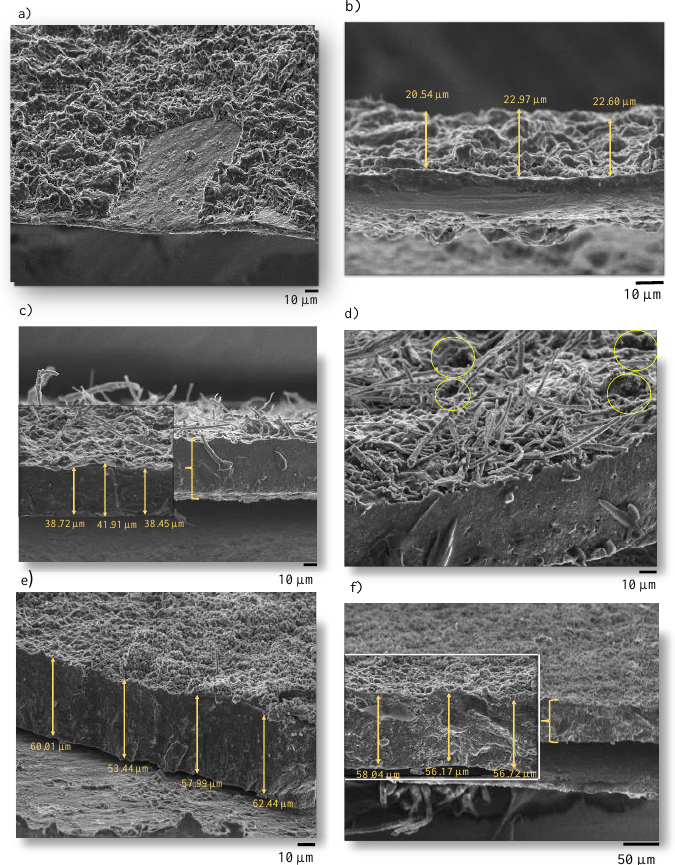
Figure 2. SEM images of the cross-sections of electrodes after testing: ( a , b ) HCSi20, ( c , d ) HCSi40, ( e , f ) HCSi60.